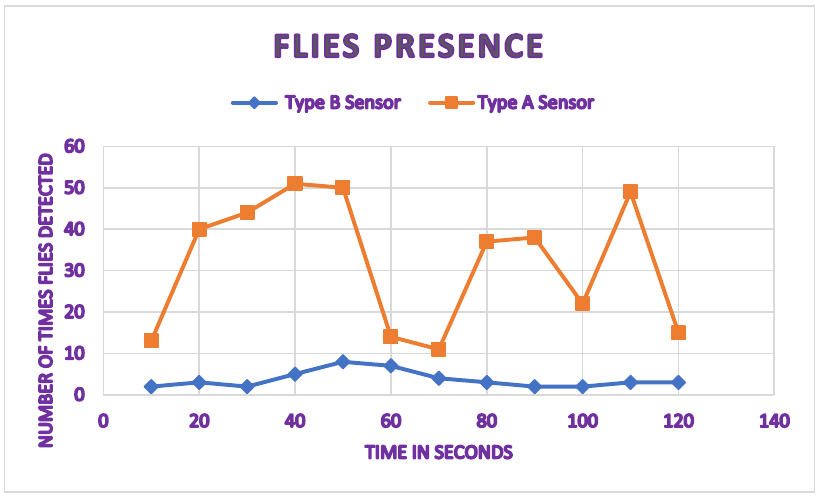
Figure 9. Housefly detection in a controlled environment (numbers are every 10 min).